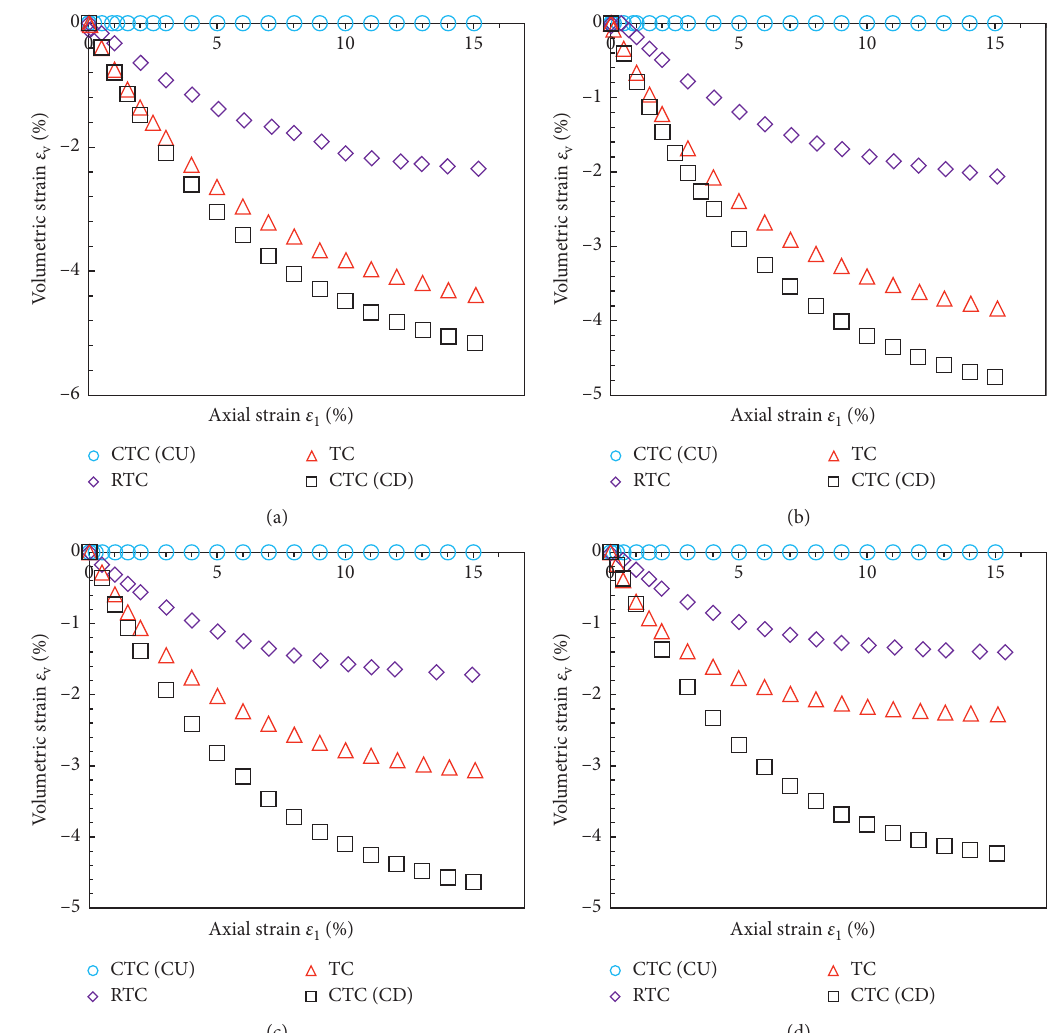
Figure 5: Volumetric strain-axial strain curves of gravelly sand under different stress paths: volumetric strain-axial strain curves (a) σ 3 � 50 kPa; (b) σ 3 � 100kPa; (c) σ 3 � 200kPa; (d) σ 3 � 400kPa.